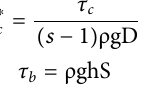
Frontiers in Earth Science |